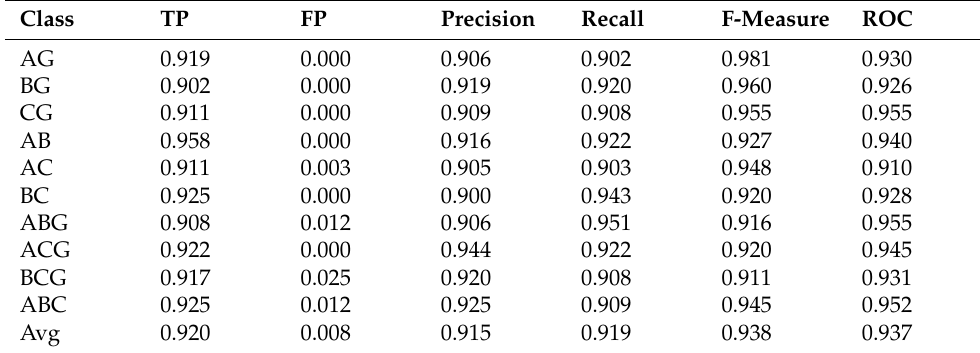
Table 17. SVM classification with two cycles post-fault with PV and WE